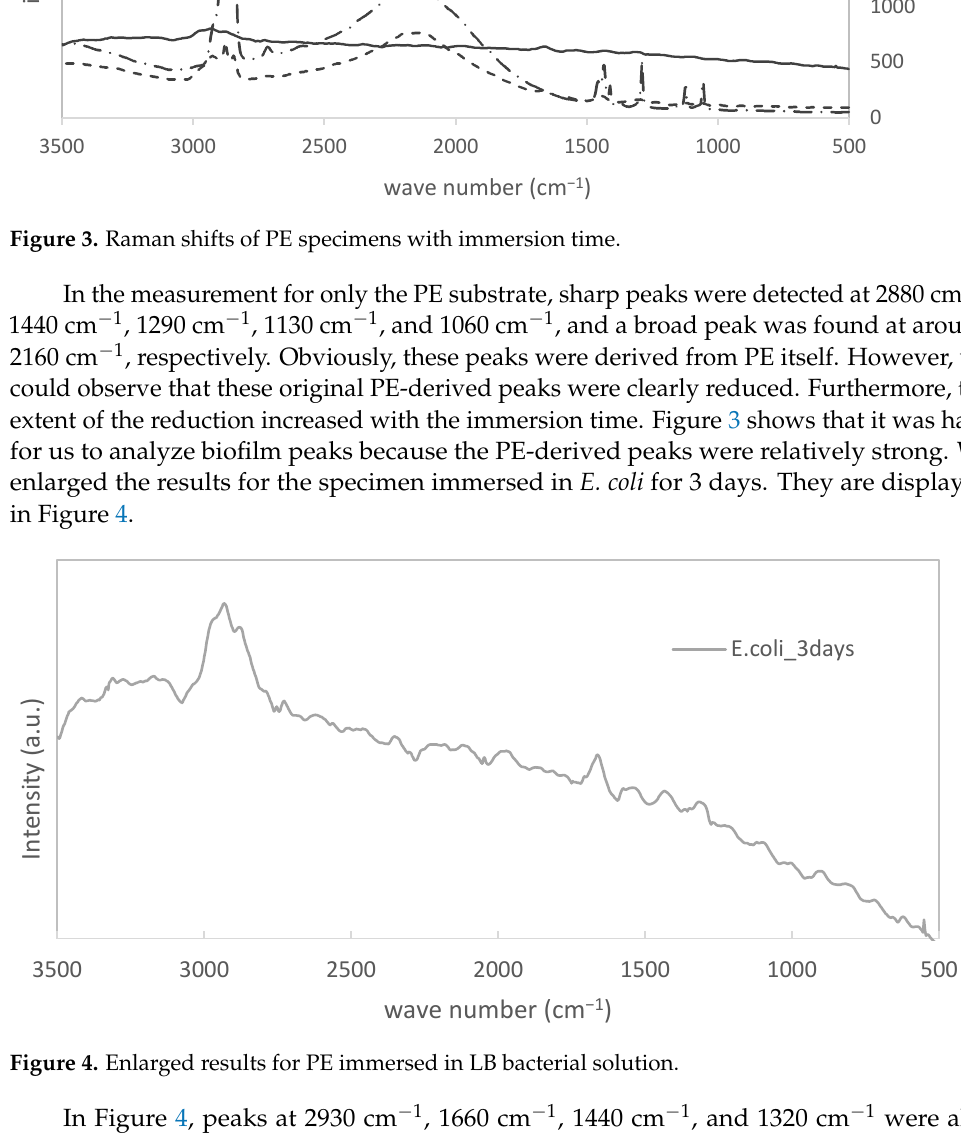
Figure 4. Enlarged results for PE immersed in LB bacterial solution. In Figure 4, peaks at 2930 cm − 1 , 1660 cm − 1 , 1440 cm − 1 , and 1320 cm − 1 were